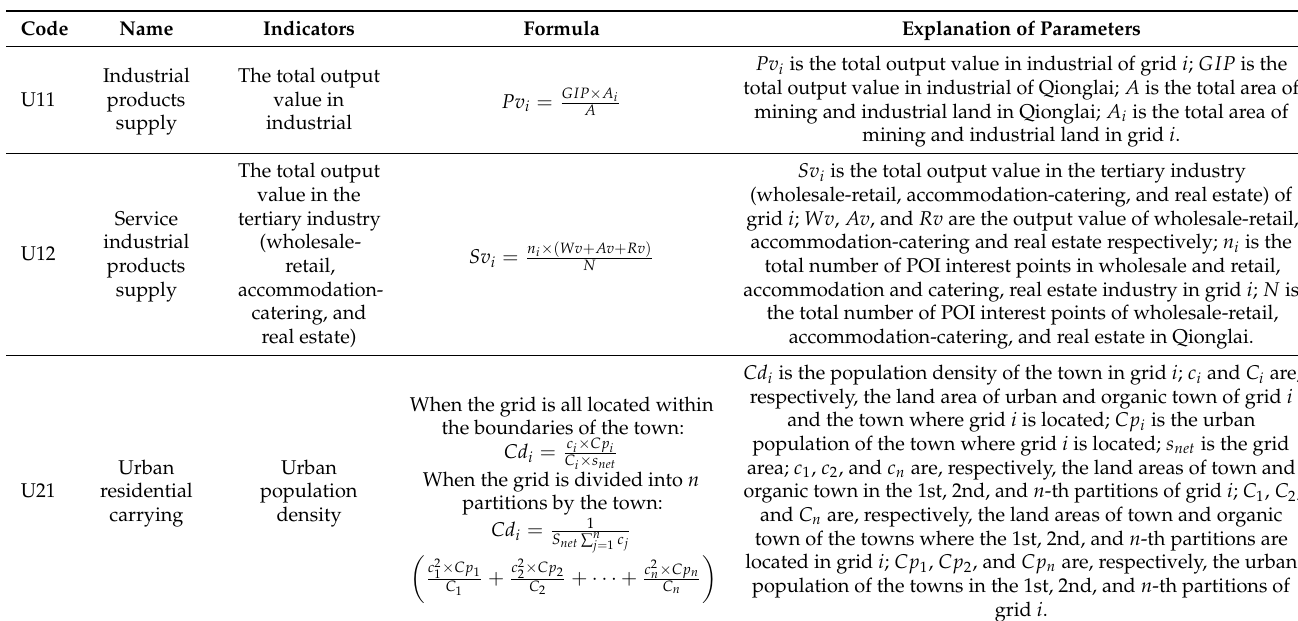
Table 3. Quantified indicators and spatial methods of the